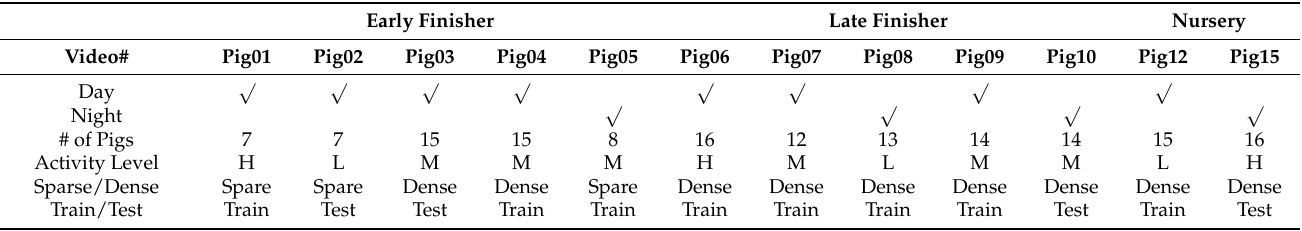
Table 1. Properties of 12 videos annotated for pig behavior tracking and performance analysis.